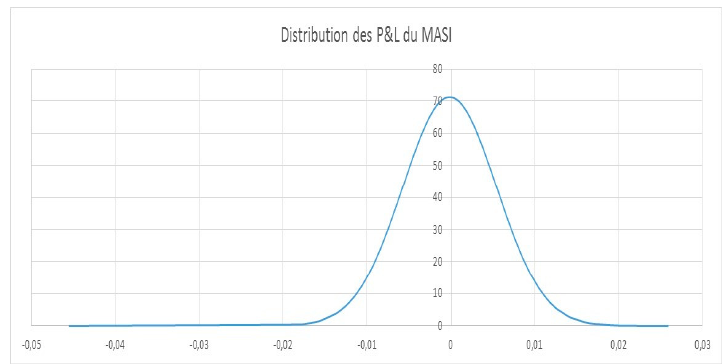
Figure 1. Jarque–Bera test statistics.